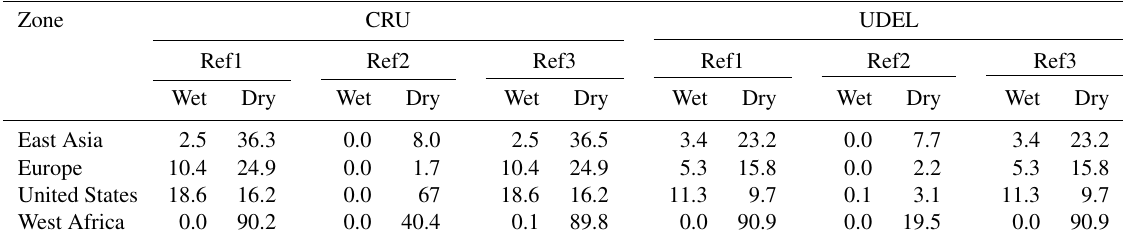
Table 4. Spatial extent (%) (number of grid points relative to the total number of terrestrial grid points) in each region of different trends of SPEI-12 values based on different reference